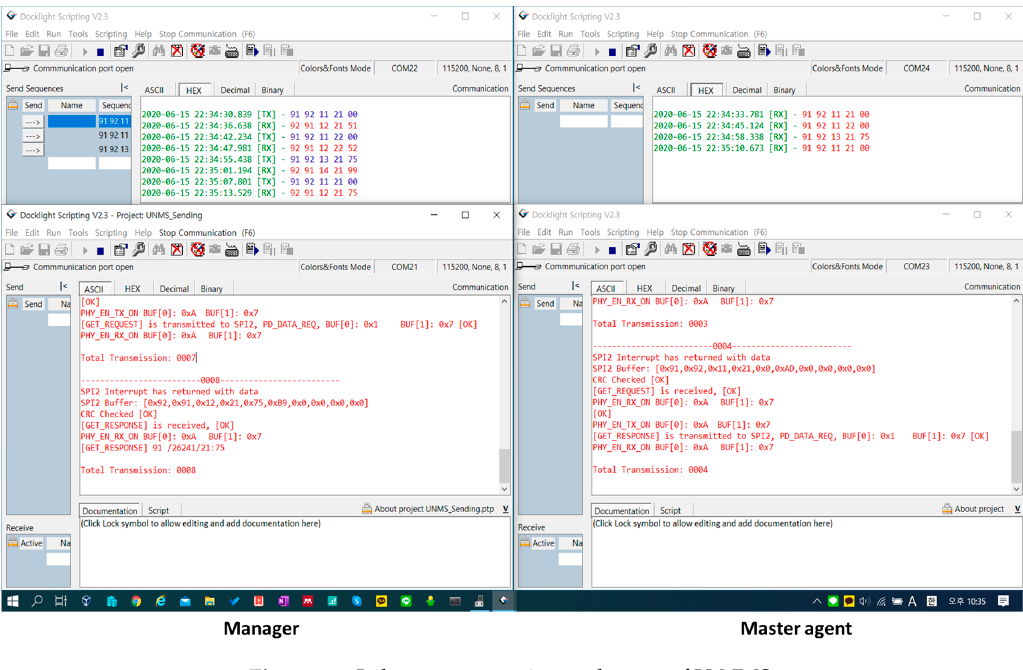
Figure 18. Laboratory experimental setup of U-NMS.